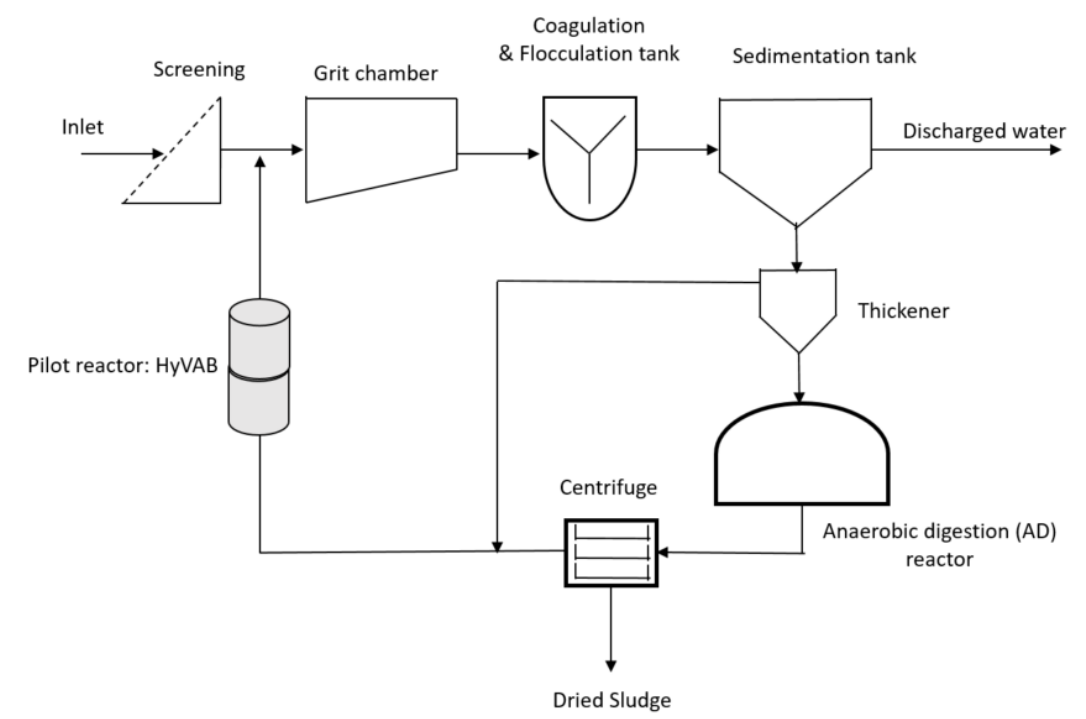
Figure 1. Flow diagram of the Knarrdalstrand wastewater treatment plant (KWWTP) integrated with the pilot hybrid vertical anaerobic biofilm (HyVAB) reactor [9].